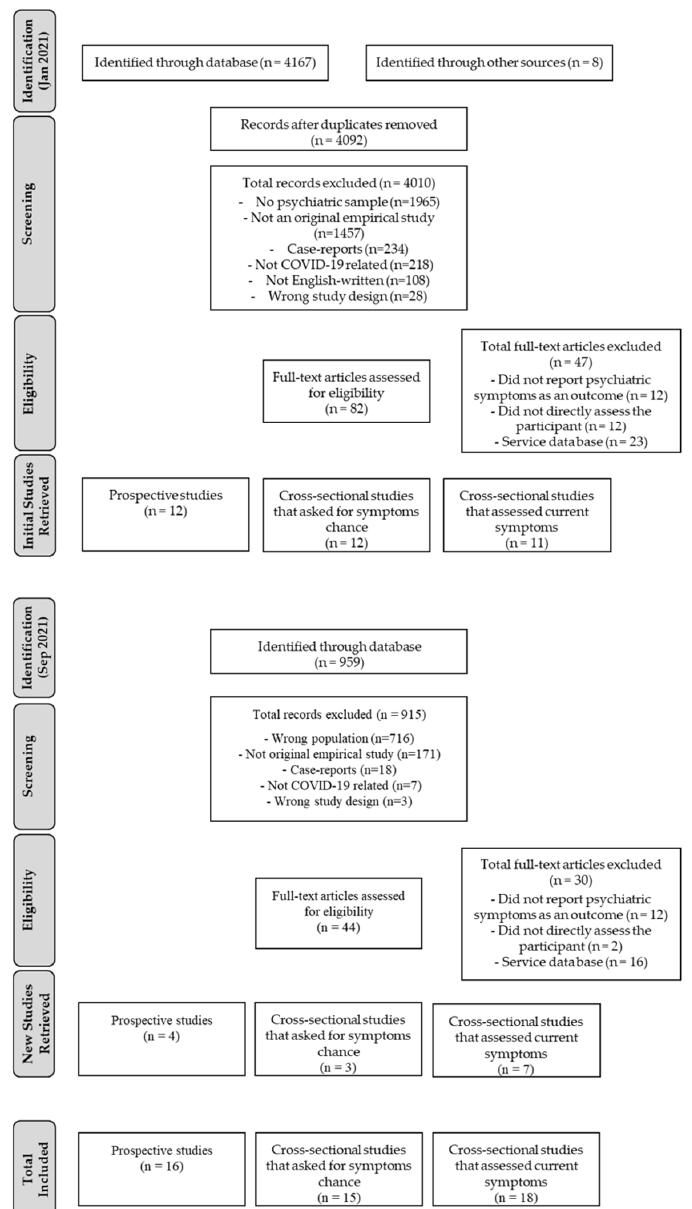
Figure 1. PRISMA flow diagram for the systematic review detailing the database searches, the number of abstracts screened, and the full texts retrieved for prospective and cross-sectional studies.